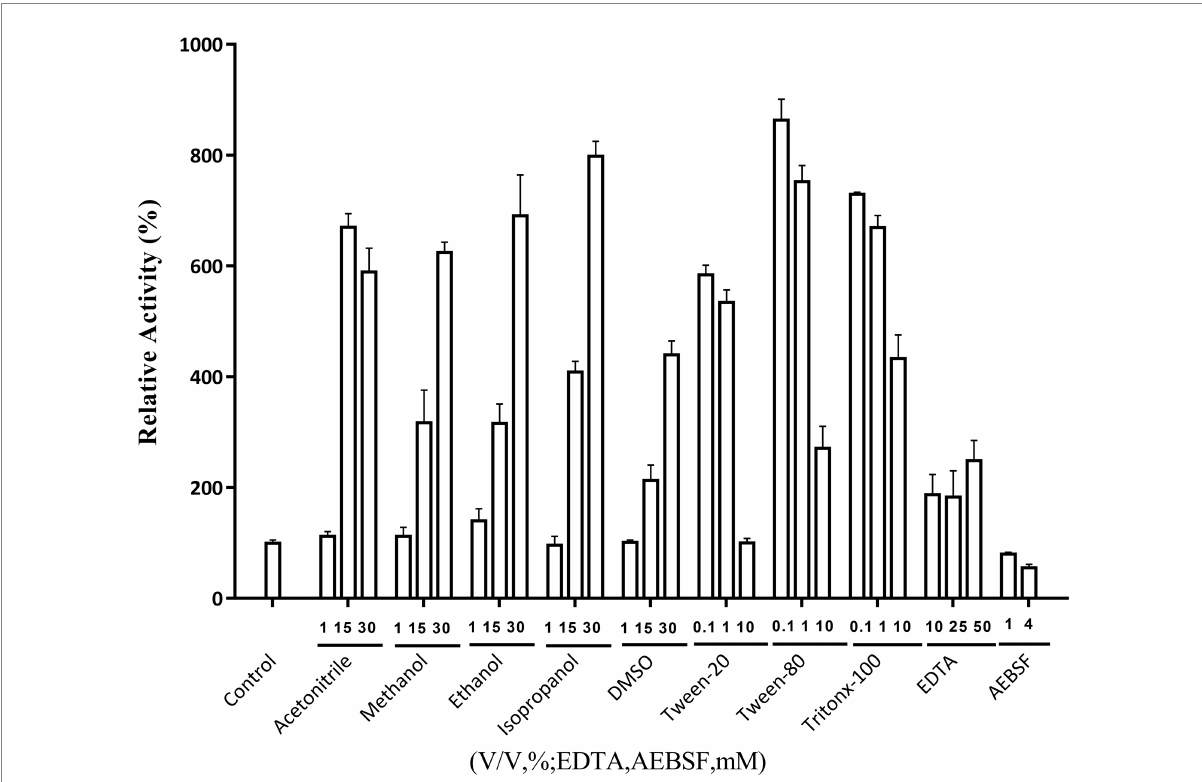
FIGURE 5 Tolerance of the recombinant Lip54q to six common commercial detergents. Six detergents used in the test include Tide washing powder, Blue Moon laundry detergent, Liby laundry detergent, Walch hand sanitizer, Axe dish soap, and Liby dish soap. The final concentration of Tide washing powder was 10 mg/ml, and the final concentrations of the remaining five detergents were 1% (v/v). Equal amounts (0.5 ml, 10 U) of recombinant enzyme solutions were added to each solution. After 1, 2, 3, 4, 6, and 24 h of treatment at room temperature, the residual activities of each mixture were determined under standard conditions. The enzyme activity of the pure enzyme solution without detergent was defined as 100%, and the relative activities of the enzyme treated with each detergent were calculated. Data points are the average of triplicate